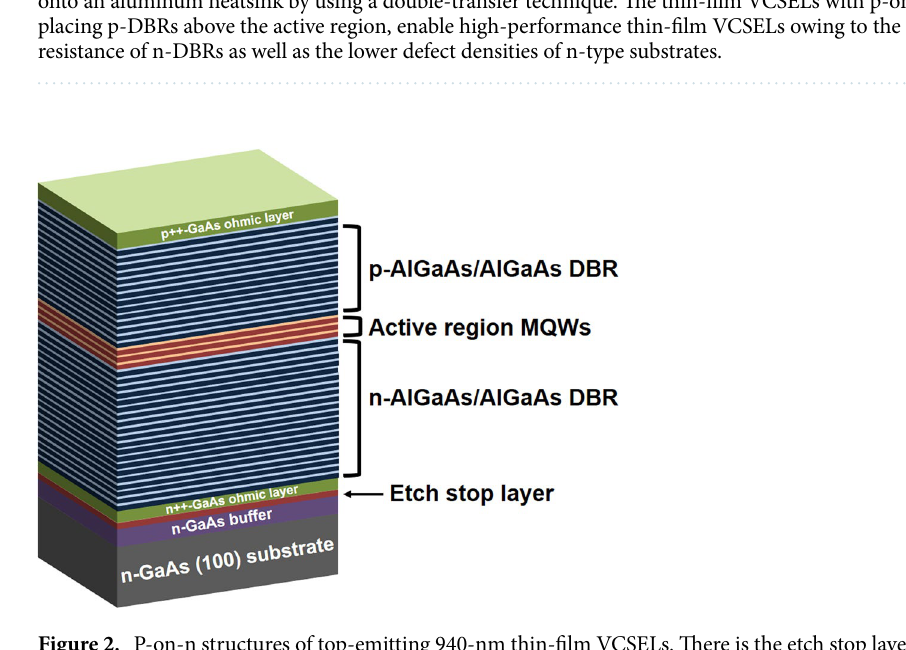
Figure 2. P-on-n structures of top-emitting 940-nm thin-film VCSELs. There is the etch stop layer inserted between the n-type GaAs ohmic layer and n-GaAs buffer in order to keep the epilayers of VCSELs intact during the removal of the n-GaAs substrate in the NH 4 OH-based etchant. The highly n-doped GaAs ohmic layer can improve the electrical characteristics of thin-film VCSELs with the removal of GaAs